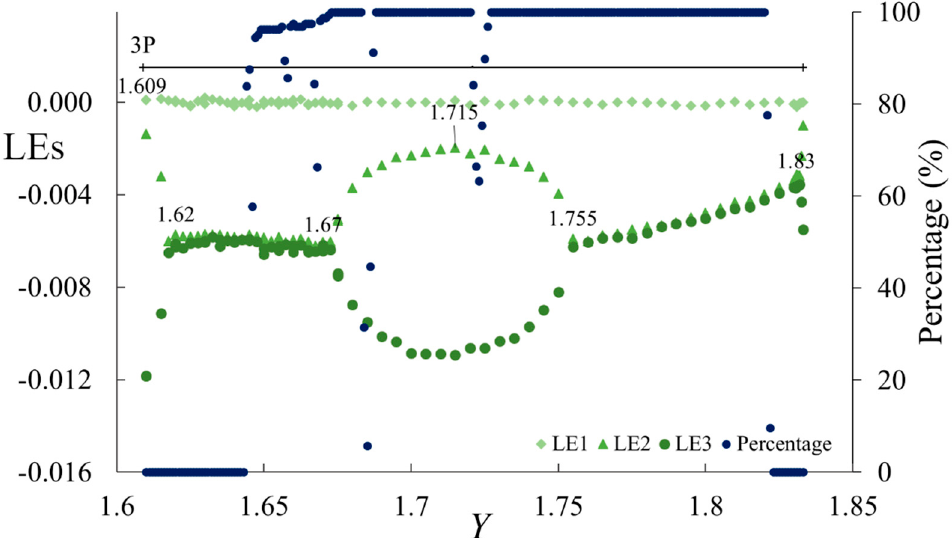
Figure 14. Schematic of LEs vs Y graphed over the domain of AIII at C = 3.0 and overlayed with the gain shift results. The right ordinate displays the percentage of times that AIII survives the gain shift.